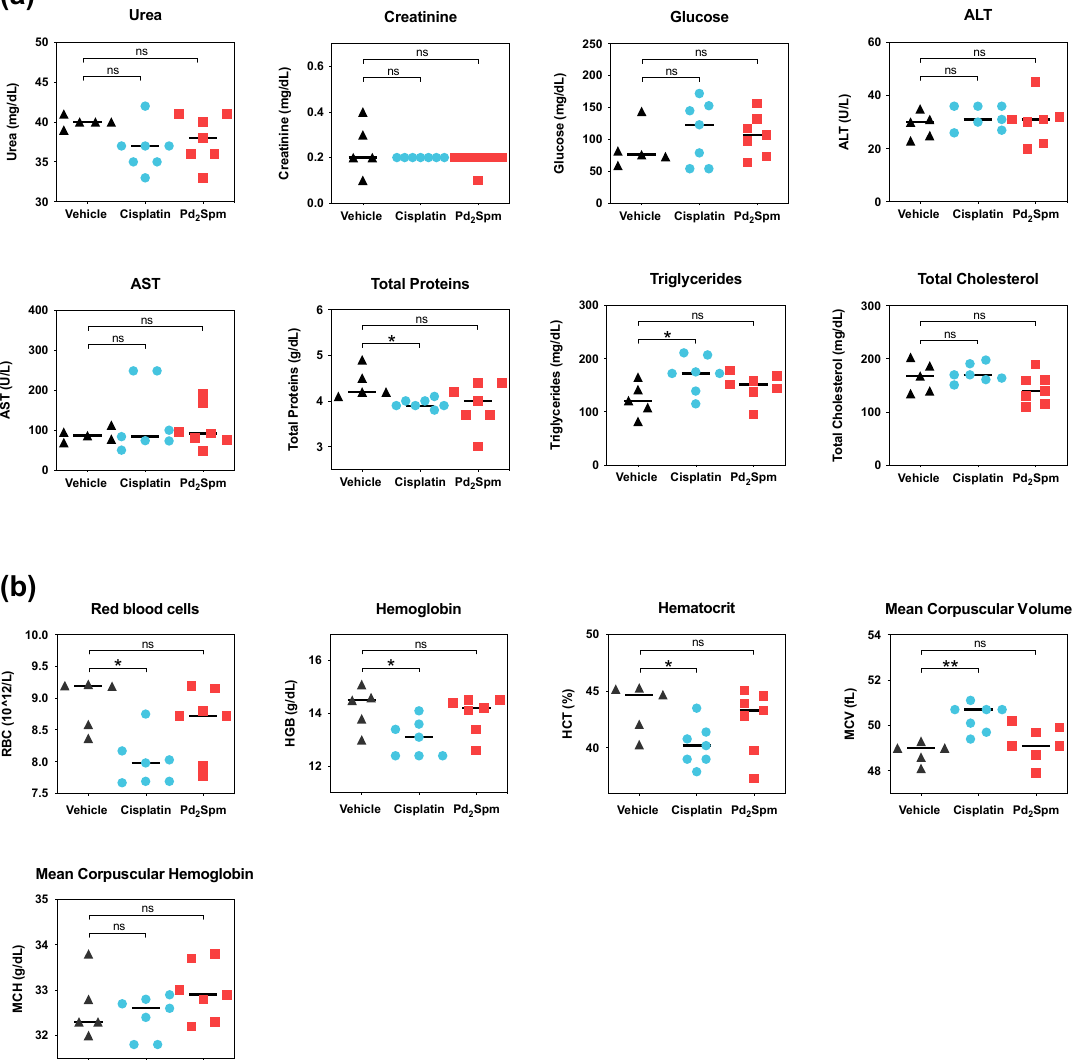
Figure 6. ( a ) Hematologic analysis and ( b ) Biochemical analysis of CBA nude female mice bearing subcutaneously implanted MDA-MB-231 triple-negative human breast cancer tumors treated with either Pd 2 Spm (5 mg/kg/day), cisplatin (2 mg/kg/day) or vehicle (PBS + 0.5% DMSO). Data are shown as individual values with medians, analyzed with Kruskal–Wallis test followed by Dunn’s multiple comparisons test. * p < 0.05, ** p < 0.01, ns = not significant. Pd 2 Spm ( n = 7), cisplatin ( n = 5), vehicle ( n = 5).